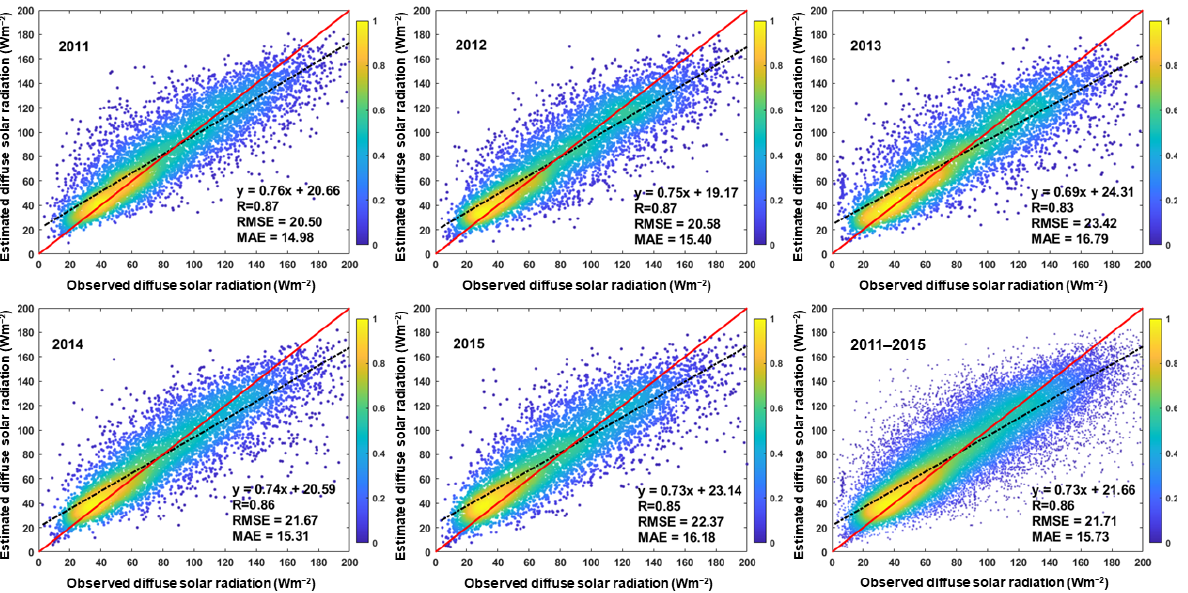
Figure 4. Density scatterplots of by-year cross-validation for ensemble model (GAM) across China.